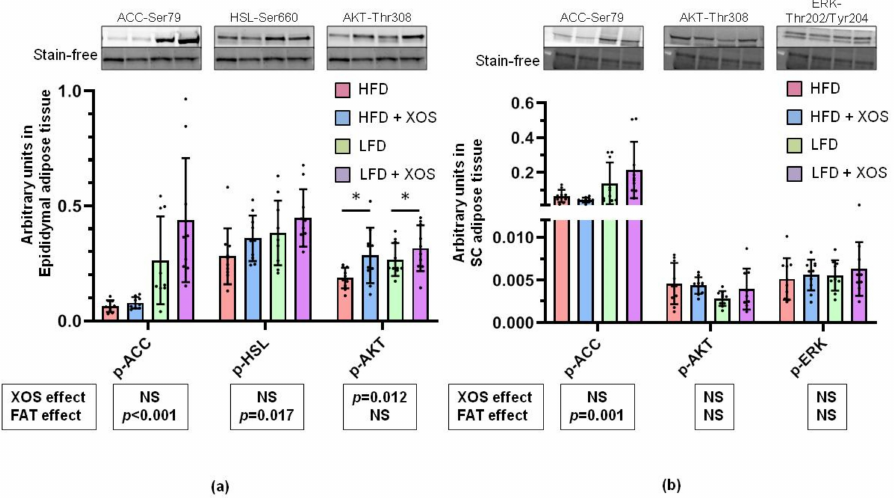
Figure 5. The effects of the diets on the phosphorylation levels of proteins in the adipose tissues. ( a ) Phosphorylation levels of ACC, HSL and AKT in epididymal adipose tissue. ( b ) Phosphorylation levels of ACC, AKT and ERK in subcutaneous (SC) adipose tissue. * indicates statistically significant ( p < 0.05) difference between the HFD or LFD group and the corresponding XOS-supplemented group as determined by Mann Whitney U